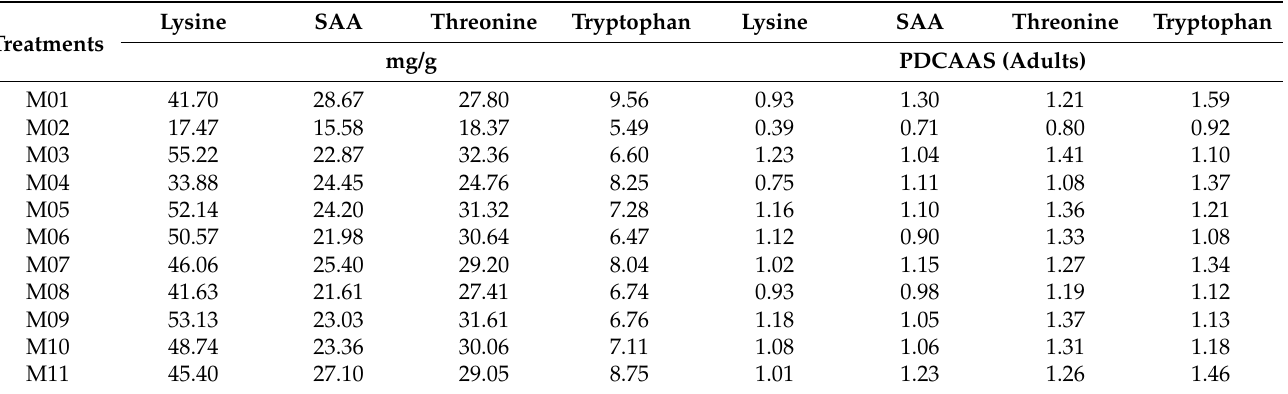
Table 3. Mix design and